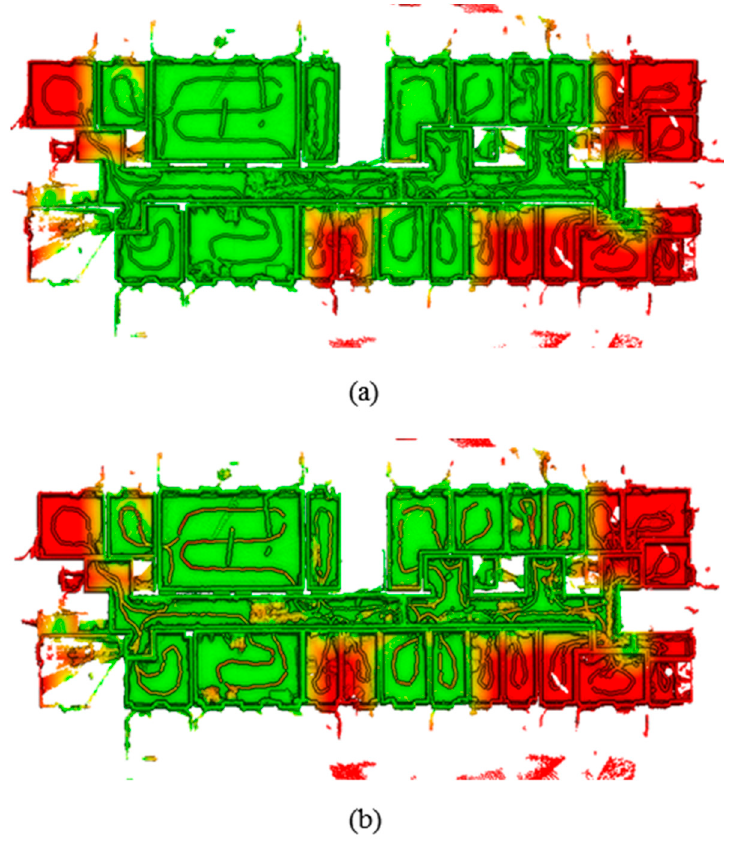
Figure 6. The distance (green < 20 cm, yellow < 50 cm, red > 50 cm) to the nearest point in ( a ) 2D and ( b ) 3D.